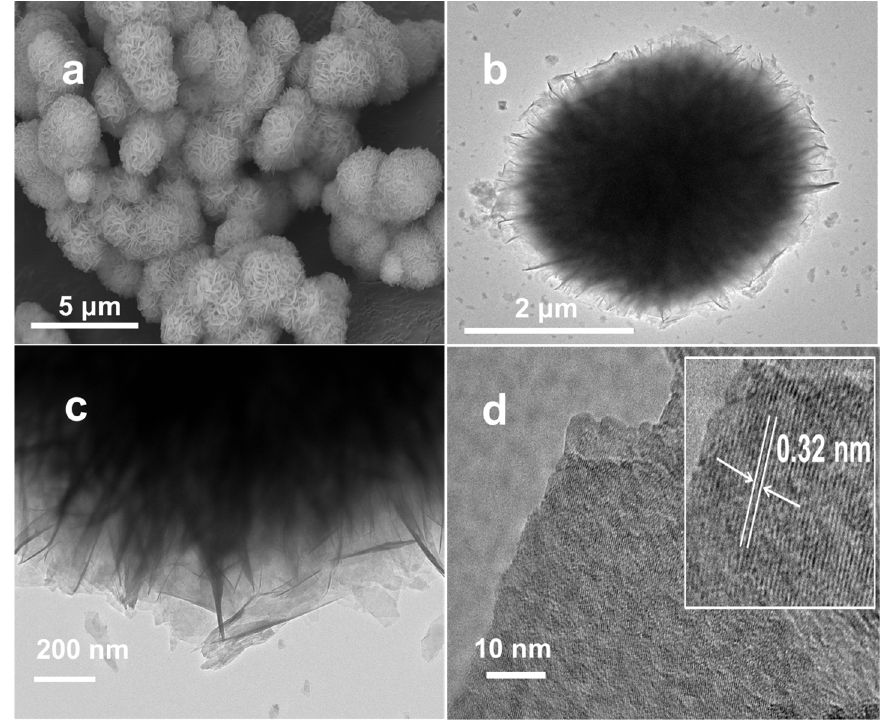
Figure 4. ( a ) Typical SEM and ( b , c ) TEM images of ZnIn 2 S 4 at different magnifications, ( d ) and HRTEM image of ZnIn 2 S 4 nanocrystallinity.